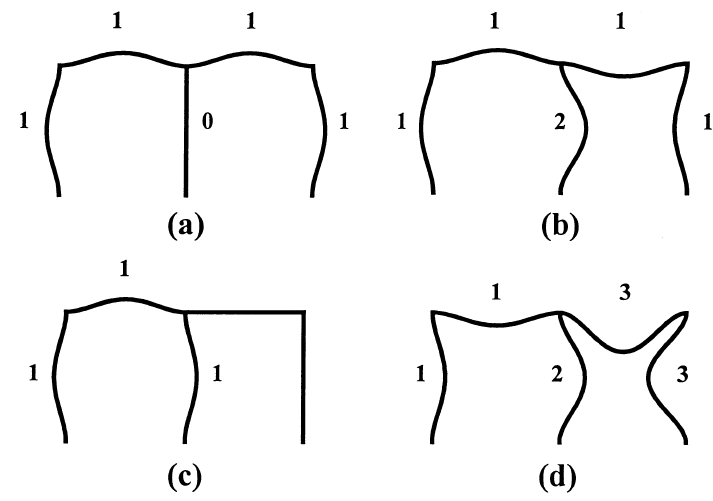
Fig. 4. Two possible pairs of orthogonal coincident modes, showing the clamped/clamped member